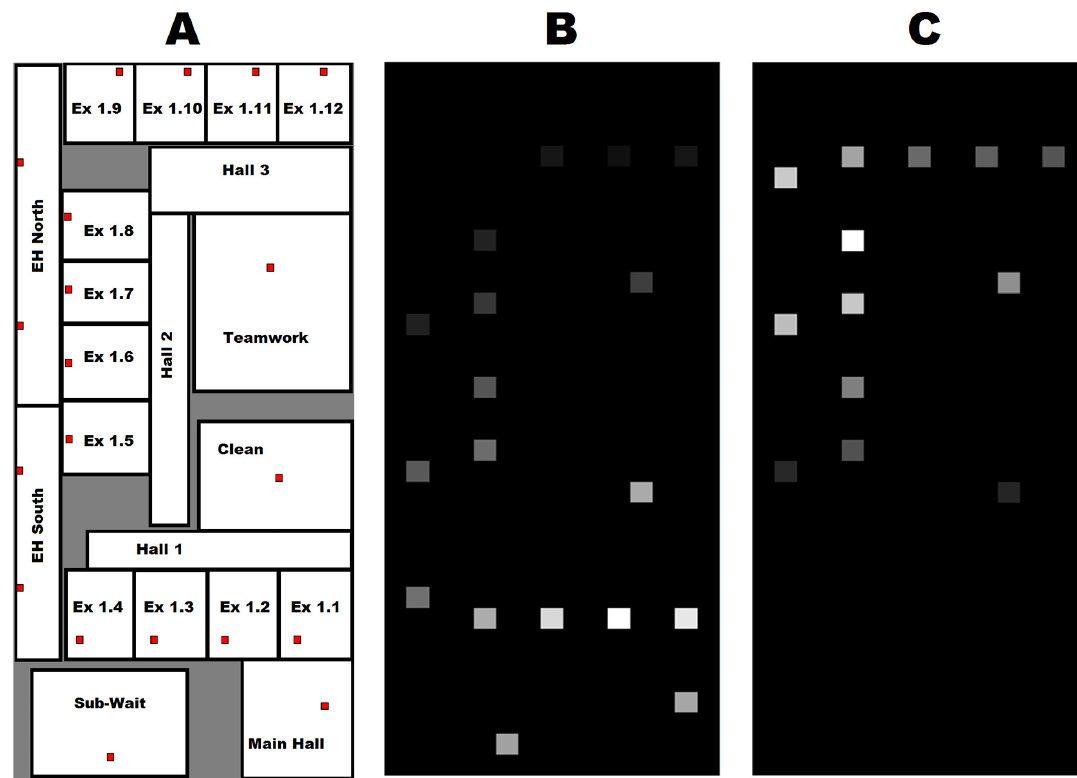
Fig 1. Spatial representation of data. A) A schematic of the floor plan for the first floor exam area where the experiments were conducted; B) A representative grayscale image used for training when the tag is in exam room 1.2, and C) A representative grayscale image when the tag is in exam room 1.8. In the grayscale images, each pixel with signal corresponds to a Raspberry Pi node, and therefore there are only 20 elements in the 34 x 15 image that vary signal as a function of time and tag position. White represents a high RSSI value and black represents a low RSSI value in the